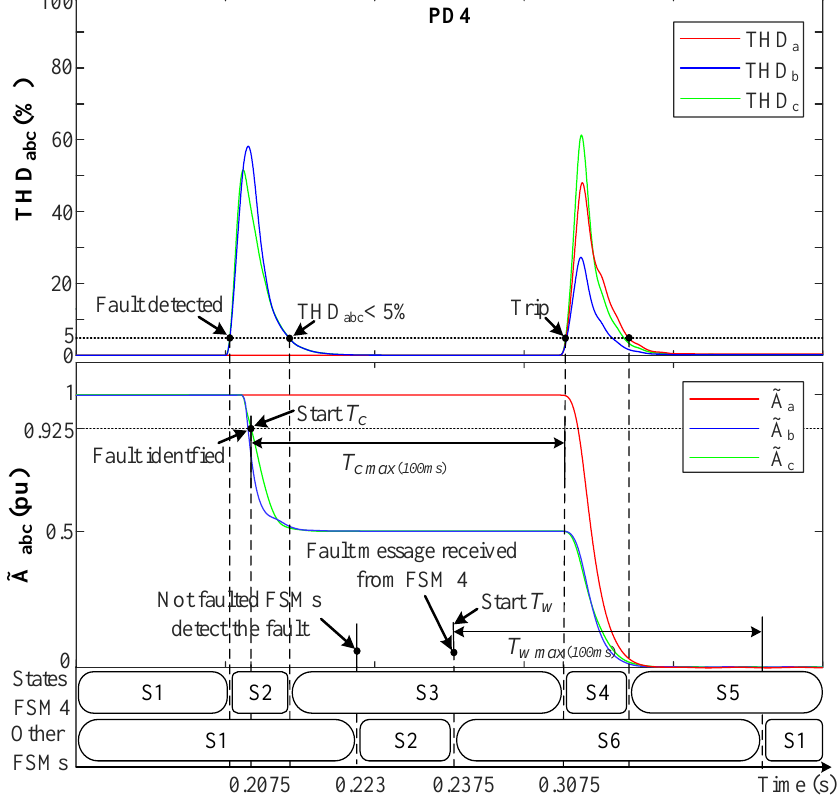
Figure 9. The system behavior with the FSMs during a 2PH fault at F2. ( Upper ) 𝑇𝐻𝐷 𝑎𝑏𝑐 . ( Lower ) 𝐴̃ 𝑎𝑏𝑐 . Figure 10a show the grid currents ( 𝑖 𝑎𝑏𝑐 ) for the 3PH fault at L3 and Figure 10b for the 2PH fault at DL2. Note in Figure 10a that only PD5 trips at 0.307 s, while the other PDs do not trip. In Figure 10b note that only PD4 trips at 0.3075 s.